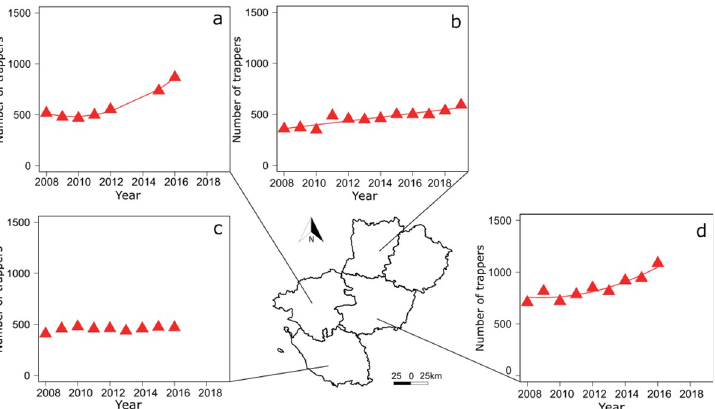
Fig 5. Variation over time in the number of trappers in 4 departments of the region Pays de la Loire. In (a) Loire- Atlantique, (b) Mayenne, (c) Vende´e, and (d) Maine-et-Loire. Data in Sarthe were not available. Curved lines represent significant trends from generalized least squares (GLS) models with an autoregressive moving average term (see S2 Table for statistical details). Source of the background map: IGN GEOFLA 1 .